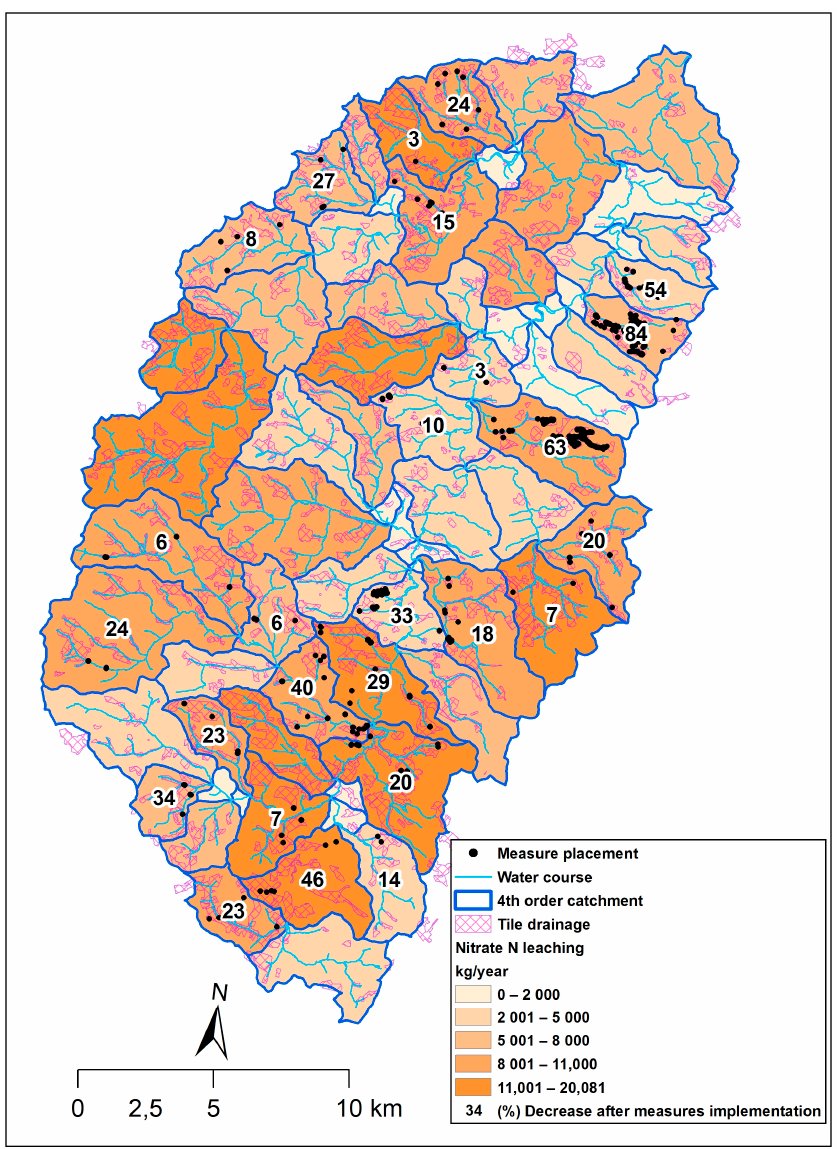
Figure 7. Reduction (%) in N-NO 3 transport via drainage runoff after adopting the control measures.